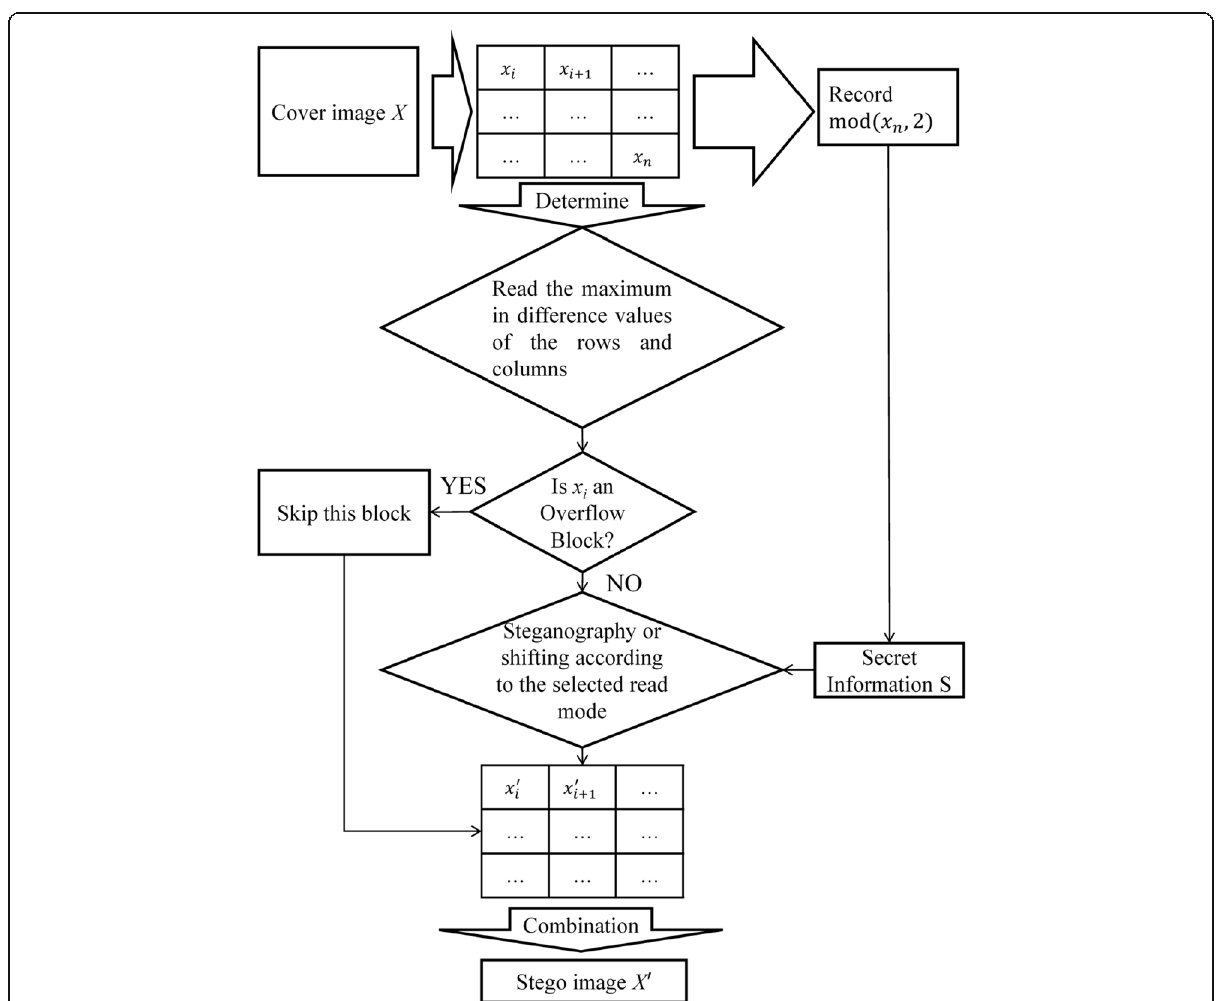
Fig. 5 Flowchart of the steganography method proposed in this study. The steganography steps proposed in this study are described as follows. (1) The LSB of the final pixel value in the digital image will be used to indicate whether the digital image is read in row or column order. (2) The cover image is read in row and column order, and the differences are calculated. (3) Block pixel ordering. (4) Construction of the location map LM (i) . (5) Compression of the location map. (6) Processing of extra information. (7) Recording of extra information. (8) Hiding of confidential information. (9) Steganography of the original cover image is carried out according to step 8 until the confidential information is hidden